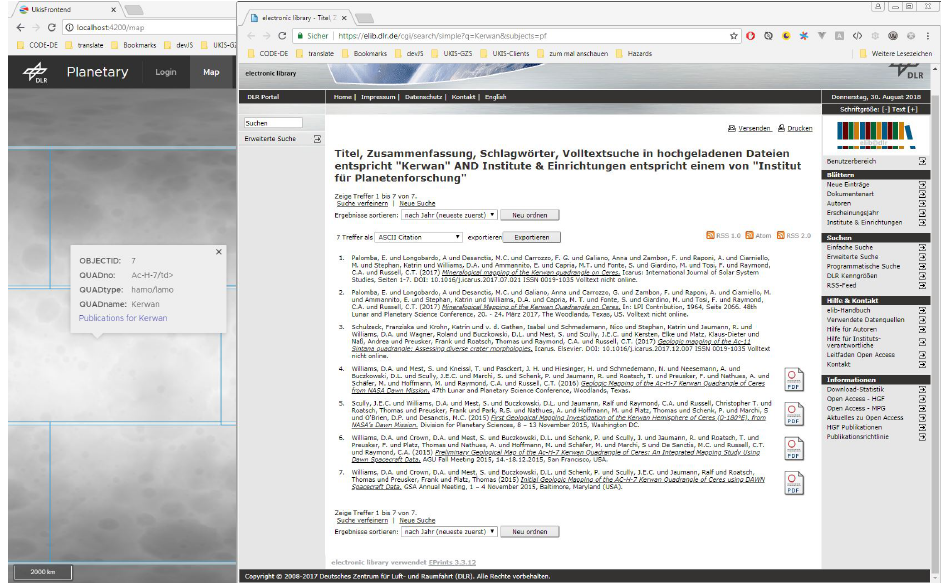
Figure 7. Publications about a specific area on Ceres are retrieved from DLR’s literature archive elib